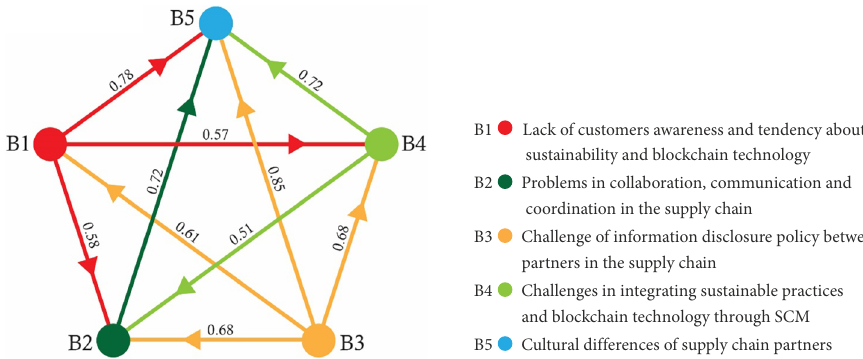
Figure 5. The visualization of the credal ranking external barriers